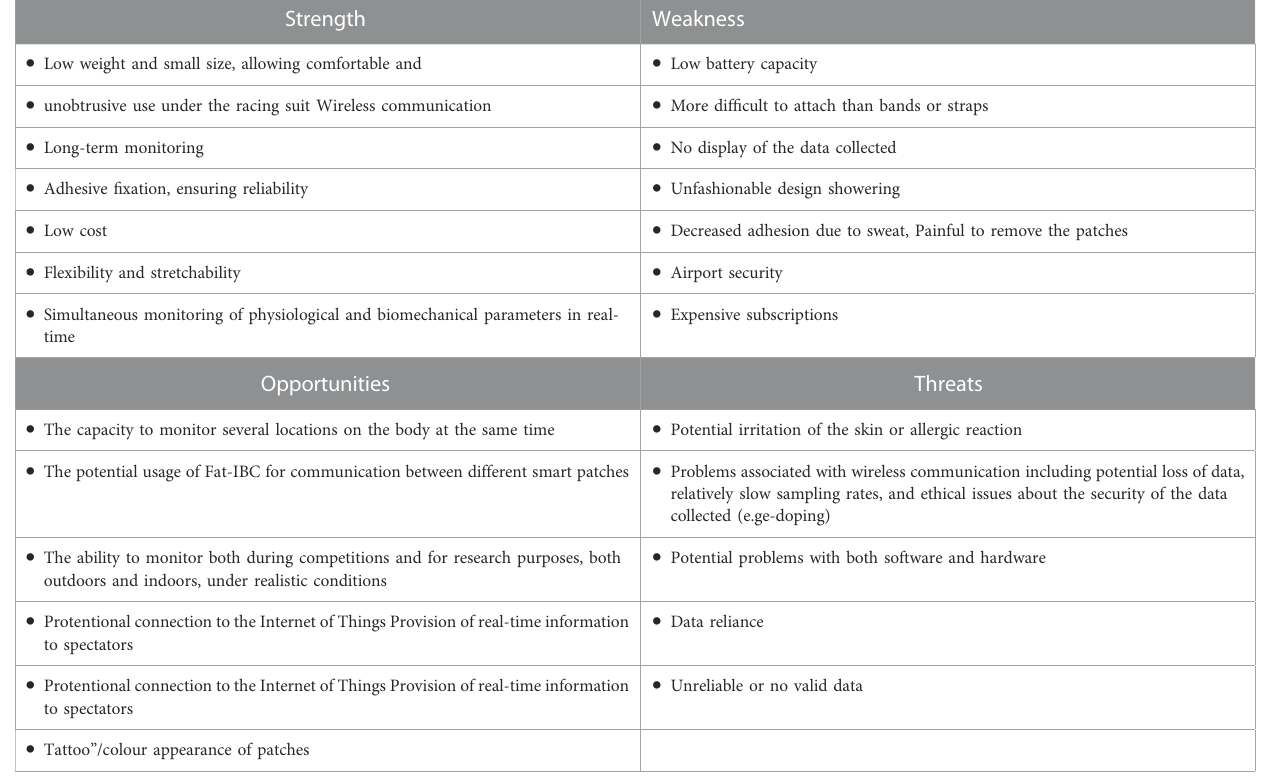
TABLE 1 A summary of the strengths and weaknesses, as well as opportunities and threats associated with the use of smart patches by athletes. Strength